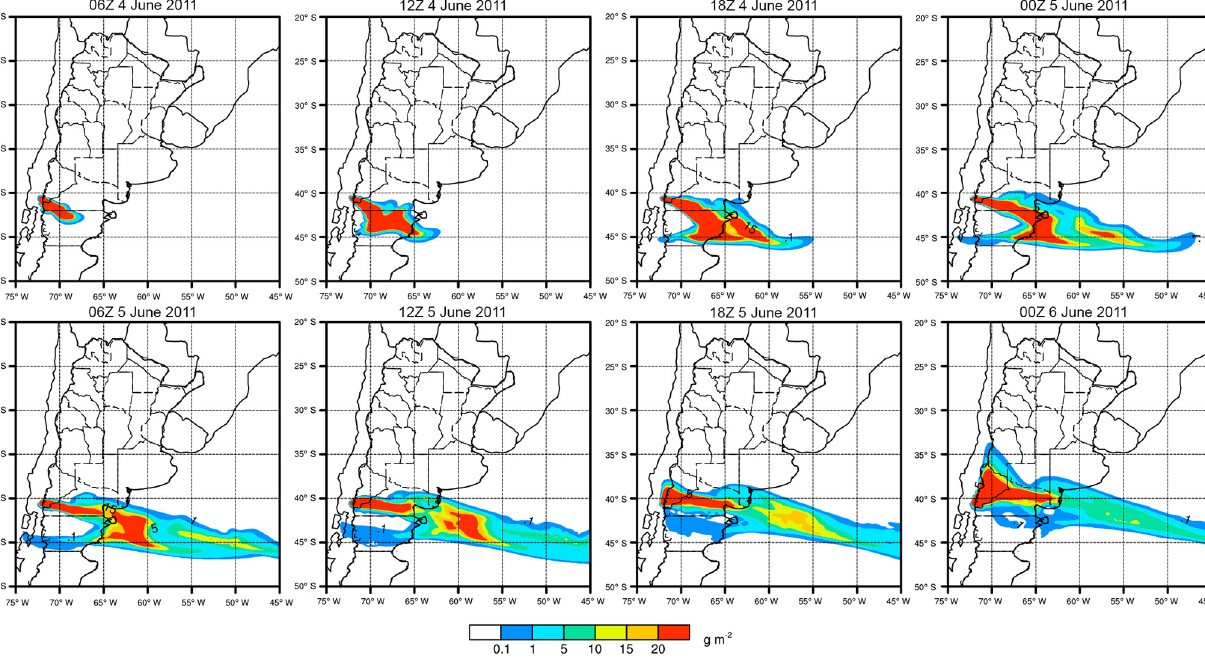
Figure 11. NMMB-MONARCH-ASH total column load (mass loading; gm − 2 ) for the 2011 Cordón Caulle